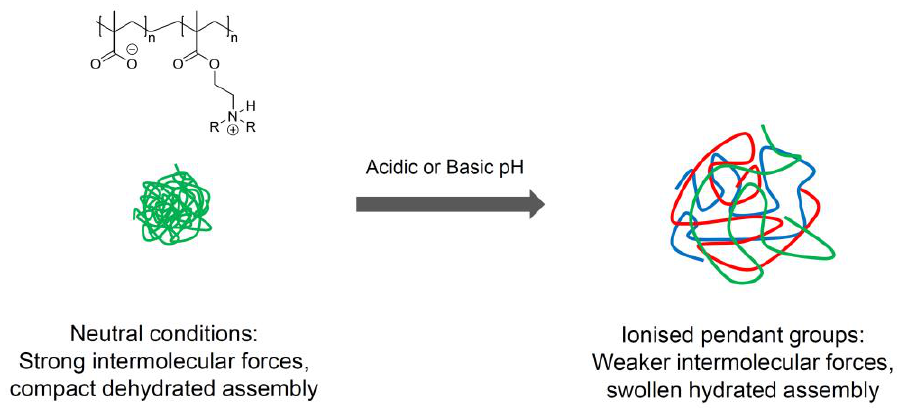
Figure 2. Representation of the switch between a neutral and charged state of pH-responsive polymer particles.